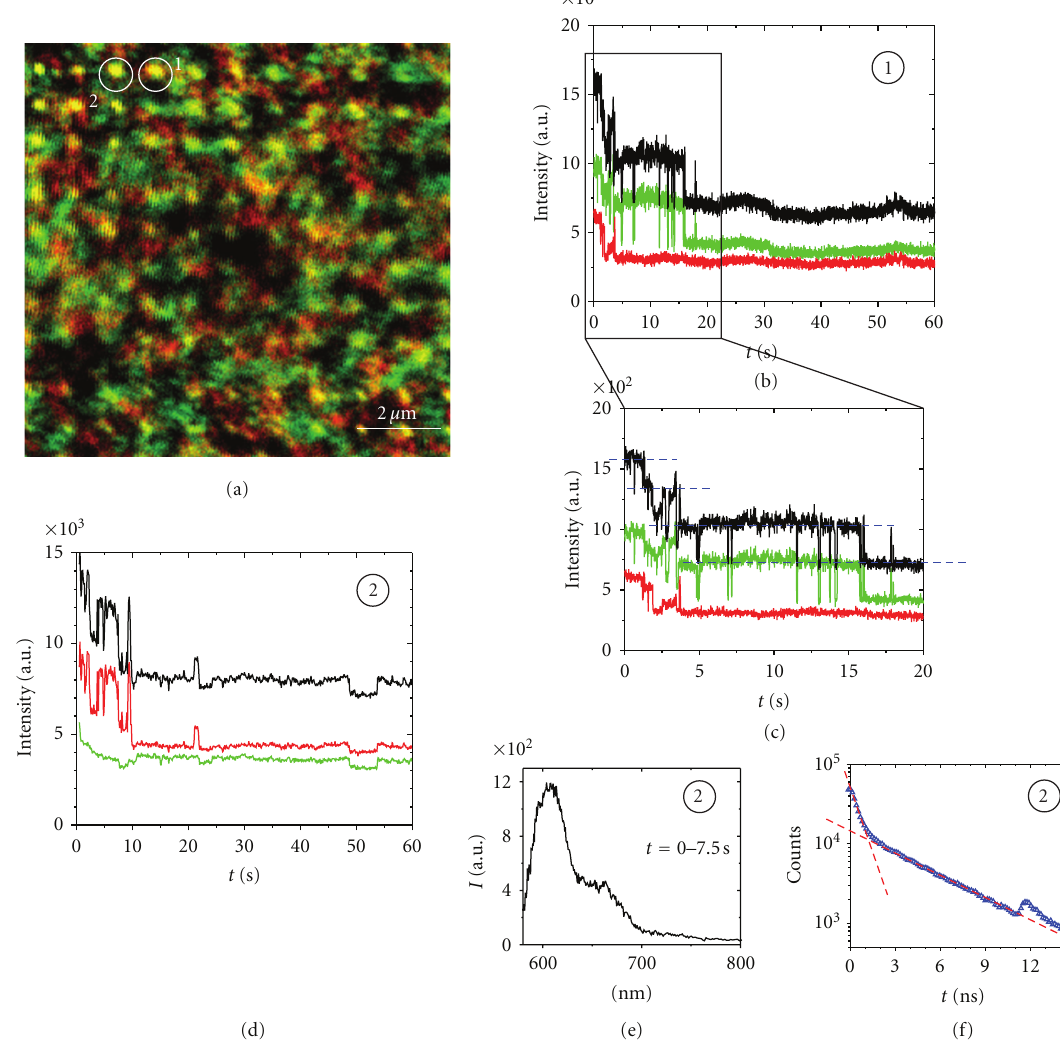
Figure 10: (a) Fluorescence image of perylene fluorescent molecules spin-coated on a substrate with dimer and monomer nanoantennas. (b) Fluorescence intensity trajectory measured at the position is indicated with circle numbered 1 in (a). Red and green trajectories indicate signals with orthogonal in-plane polarizations, while the black line indicates the total intensity. The intensity trajectory at position (1) shows a clear multilevel intensity blinking and bleaching reminiscent of molecular fluorescence. (c) Zoom in to the first 20 s where the four intensity levels are indicated with dashed blue lines. (d) The intensity trajectory measured at position number 2 in (a) displays similar blinking. (e) The fluorescence spectrum is recorded in the initial 7.5 s of the trajectory at position 2, with the spectra measured between t = 30 and t = 60 s subtracted. The resulting spectrum is a typical emission spectrum of our perylene molecule. (f) Fluorescence lifetime is measured at position 2. Dashed lines in the lifetime graph indicate exponential fits with lifetimes of τ 1 = 0 . 4 ns and τ 2 = 5ns,